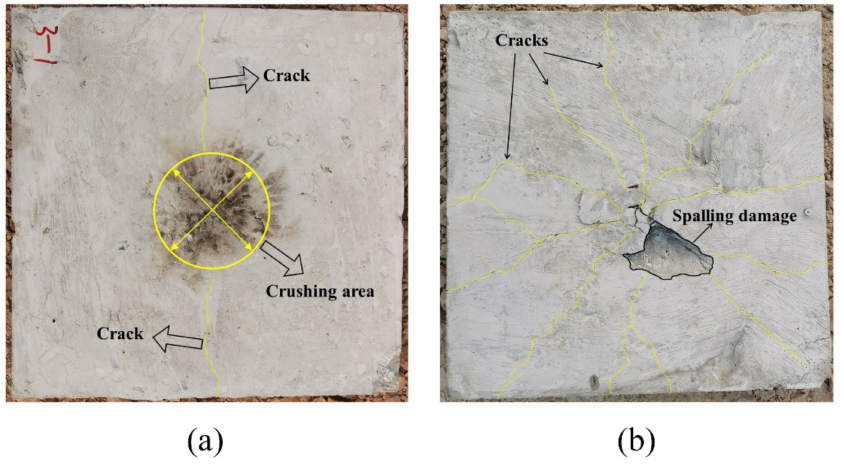
Figure 17. Test results: ( a ) top surface; ( b ) bottom